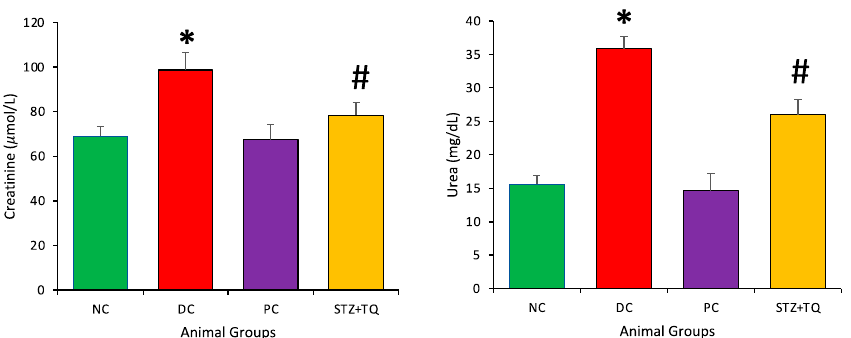
Figure 8. The kidney function test profile in different groups of rats after 8 weeks of follow up. Rats were uniformly divided into each group ( n = 8 per group). Data are means ± standard error of the mean (SEM). Groups: Normal control (NC); disease control (DC) i.e., STZ-treated group; positive